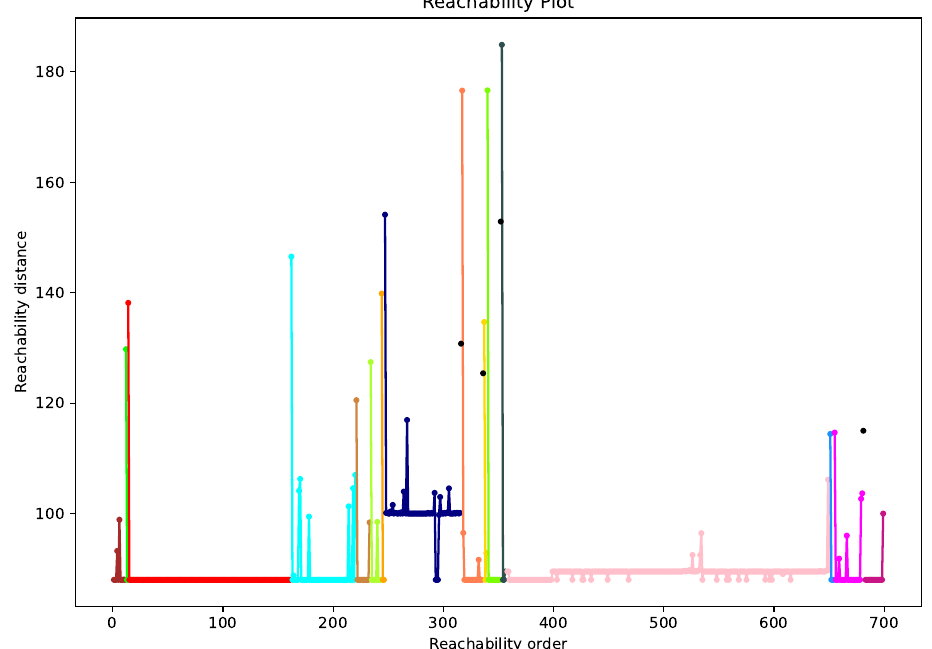
Figure 5. Reachability plot for data collected at the city square Piazza Università in Catania in an early morning 15-min interval. Points of the same cluster have the same